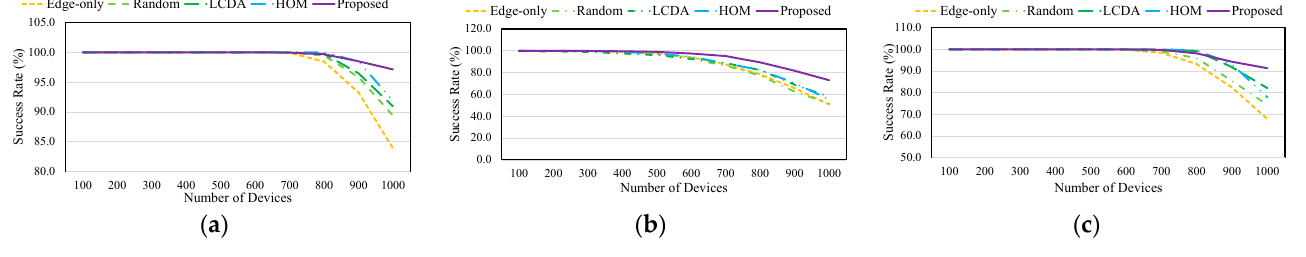
( c ) Figure 8. Completion time of Task 1, Task 2, and Task 3: ( a ) Task 1; ( b ) Task 2; ( c ) Task 3. LCDA collaborates with other edge servers based on the classified tasks and selects an edge server that can allocate sufficient computing resources for latency-sensitive tasks, such as Task 2. LCDA shows 64% lower than Random . By contrast, LCDA does not effi- ciently collaborate on latency-tolerant tasks, such as Task 1 and Task 3; hence, the com- pletion time increases as the number of devices increases. LCDA shows a low success rate due to the decrease in computing resources as the number of tasks assigned to the edge server increases. HOM calculates the shortest path according to the network bandwidth and task size. This scheme effectively reduces the communication time, resulting in low completion times for all tasks. However, HOM cannot determine optimal collaboration according to the task deadline. For this reason, HOM shows lower success rates (4.3% in Task 2 and 5.4% in Task 3) than LCDA . The proposed scheme predicts the completion time according to the characteristics of the task and selects the optimum collaboration target that reduces the completion time for each task. In particular, the proposed scheme allocates computing resources to ensure high success rate of each task. When the number of devices is 1000, the completion times of Task 1 and Task 2 using the proposed scheme are 45% and 26% higher than that of the LCDA . The reason is that the proposed scheme allocates computing resources regardless of task requirements. Nevertheless, the proposed scheme improves QoE by achieving a 61% low completion time for Task 3. 5. Conclusions In this paper, we propose a resource prediction-based edge collaboration for improv- ing QoE. The proposed scheme probabilistically determines the optimal collaboration tar- get to improve QoE between servers based on predicting computing resources when the edge server receives a task. According to the delay model, the collaboration target is de- termined using a greedy algorithm based on the task completion time. The amount of computing resources allocated to a task is determined based on the processing and buff- ering times of the task. Experimental results show that the proposed scheme achieves a low completion time and high success rate according to computing resource allocation and greedy-based edge collaboration. Consequently, the proposed scheme outperforms the QoE of the existing edge collaboration schemes for various tasks.